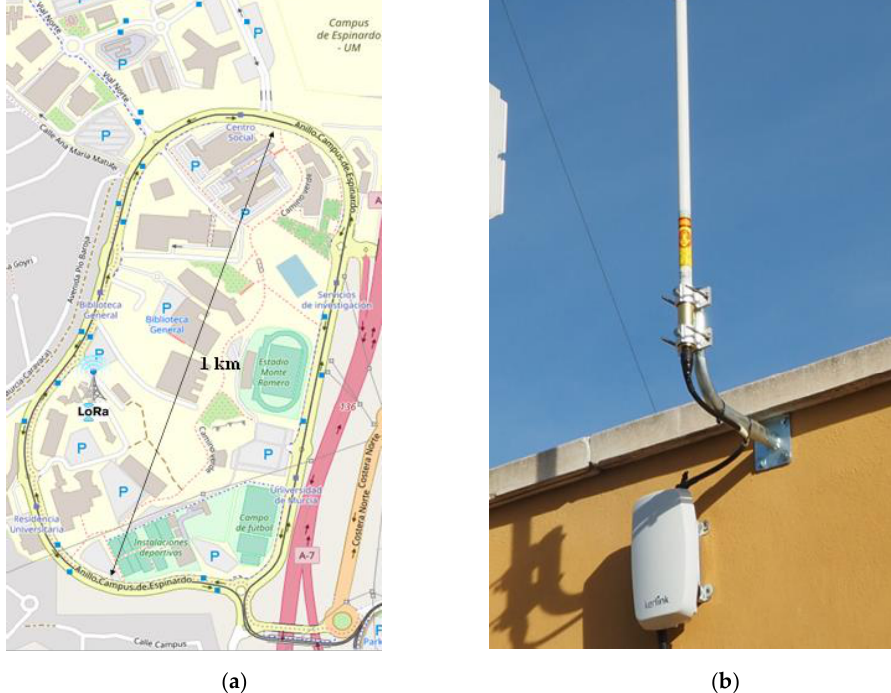
Figure 5. LoRaWAN deployment: ( a ) deployment map; ( b ) LoRaWAN gateway detail.